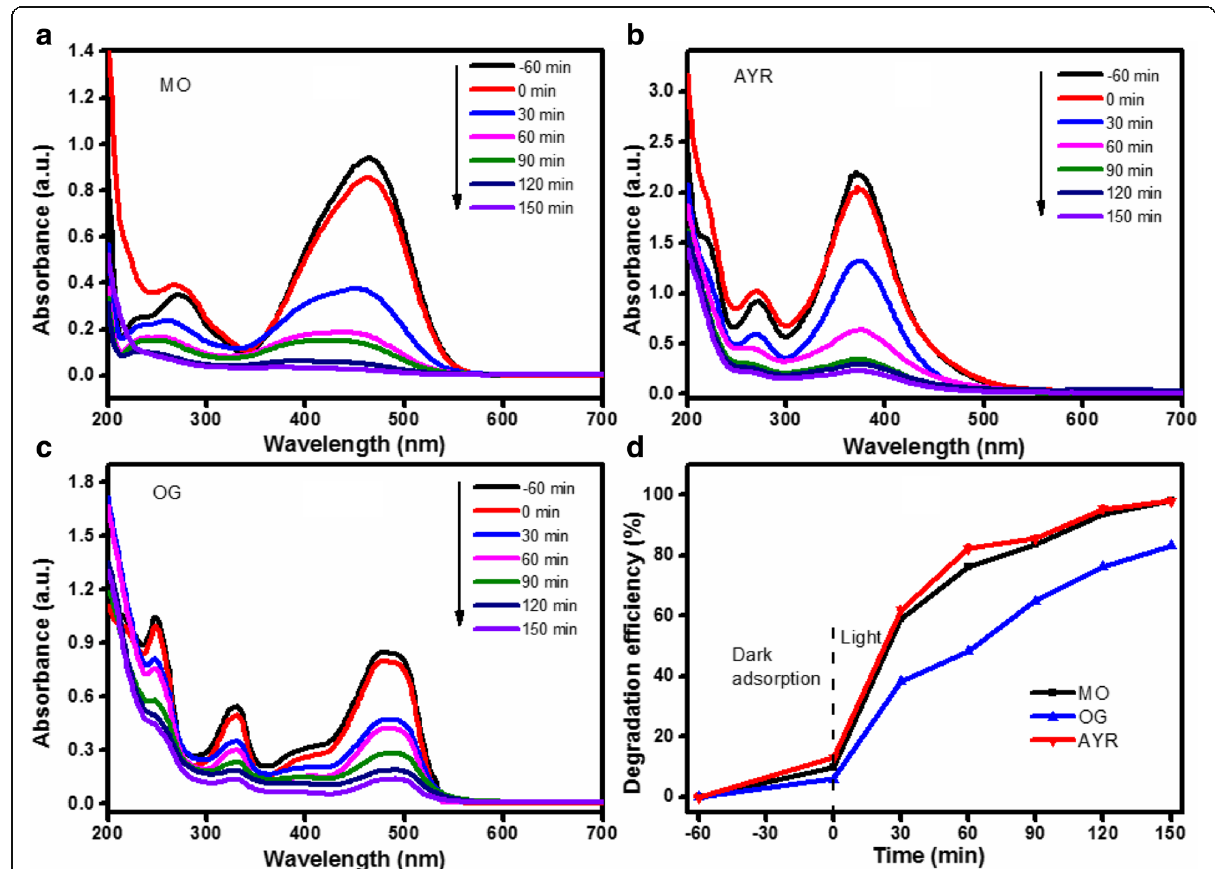
Fig. 11 UV-vis spectra of a MO, b AYR, and c OG at different irradiation times, and d degradation efficiency curves of different dyes in the presence of ZnO/Fe 3 O 4 /g-C 3 N 4